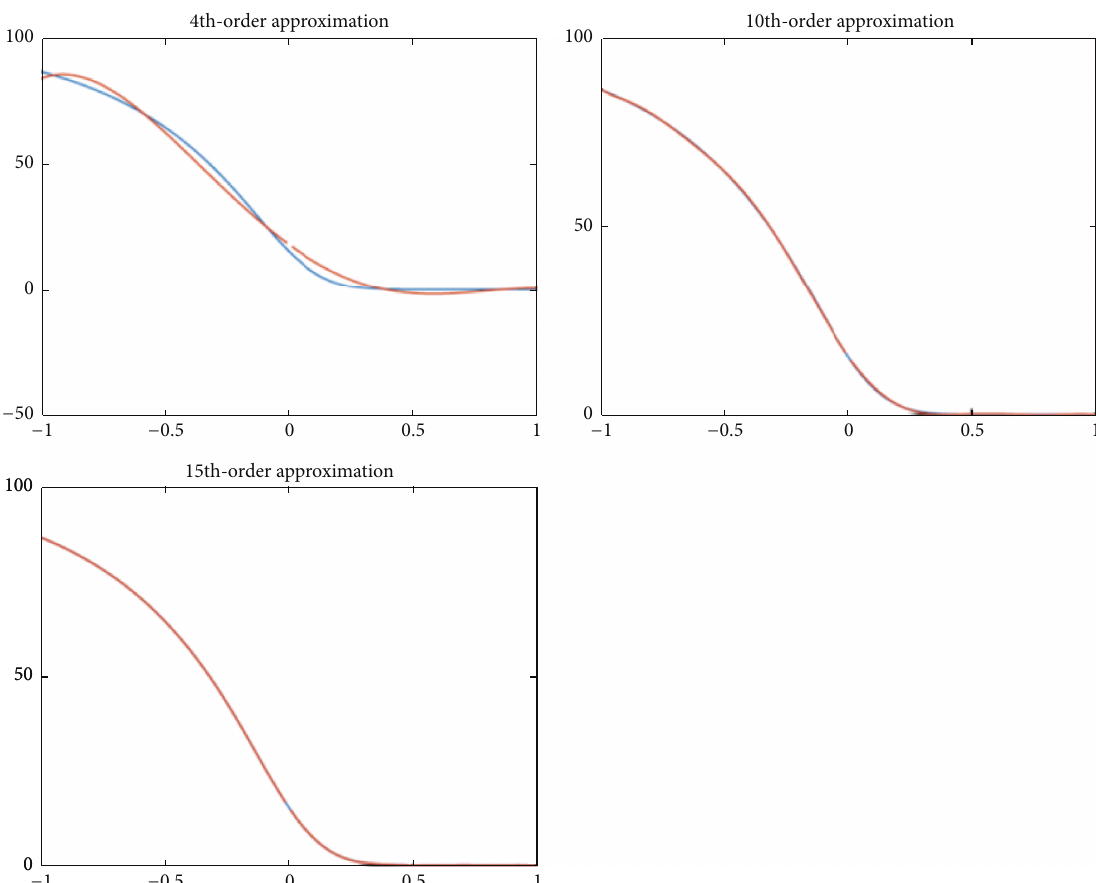
Figure 2: Approximations of the conditional price based on Chebyshev polynomials using the benchmark set of parameters. Clockwise, from top left are 4th, 10th, and 15th orders, respectively. The truncation interval is [−1.5, 1.5] .